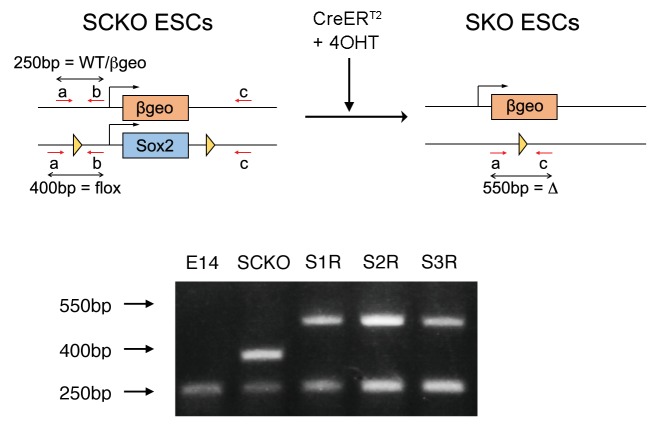
(TOP) Strategy for genotyping the Sox2 deletion by PCR.Primers a and b flank the position of the loxP site 5’ to Sox2; primer c flanks the loxP site 3’ to Sox2. Amplification of wild-type (WT) and βgeo targeted alleles produces a 250 bp band whereas the loxP-flanked Sox2 allele (flox) produces a 400 bp band. Upon Cre-mediated recombination, the deleted (Δ) allele produces a 550 bp band amplified by primers a + c. (BOTTOM) Wild-type E14Tg2a ESCs (E14) exhibited only the 250 bp band. SCKO ESCs exhibited both 250 bp and 400 bp bands whereas Sox2-/- S1R, S2R and S3R ESCs retained the 250 bp band and exhibited the 550 bp band corresponding to the deleted allele.